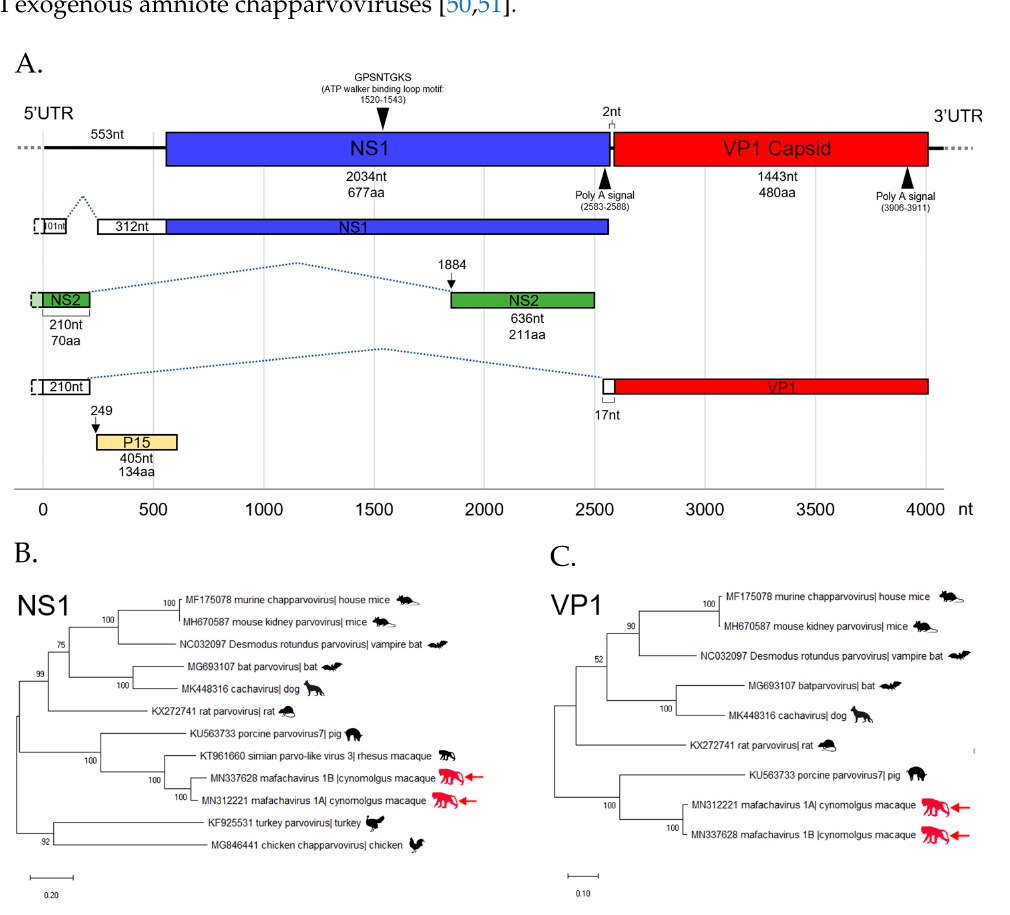
Figure 5. ( A ) The diagram shows the genomic structure and predicted splicing pattern of the novel chapparvovirus ( Macaca fascicularis chapparvovirus 1 ; mafachavirus 1A) identified from wild cynomolgus macaque (WMF03). The assembled genome contains two major open reading frames (ORFs); non-structural protein 1 (NS1) and viral capsid protein 1 (VP1) and the sequence of NS2. The functional motif and Poly A signal are also illustrated. The phylogenetic trees of Mafachavirus 1A and 1B were constructed based on ( B ) the NS1 region and ( C ) the VP1 region. The trees include the reference sequences from other chapparvovirus members. Nodes indicate % of bootstrapping value (1000 rounds). The tree was scaled by the number of changes per amino acid site.